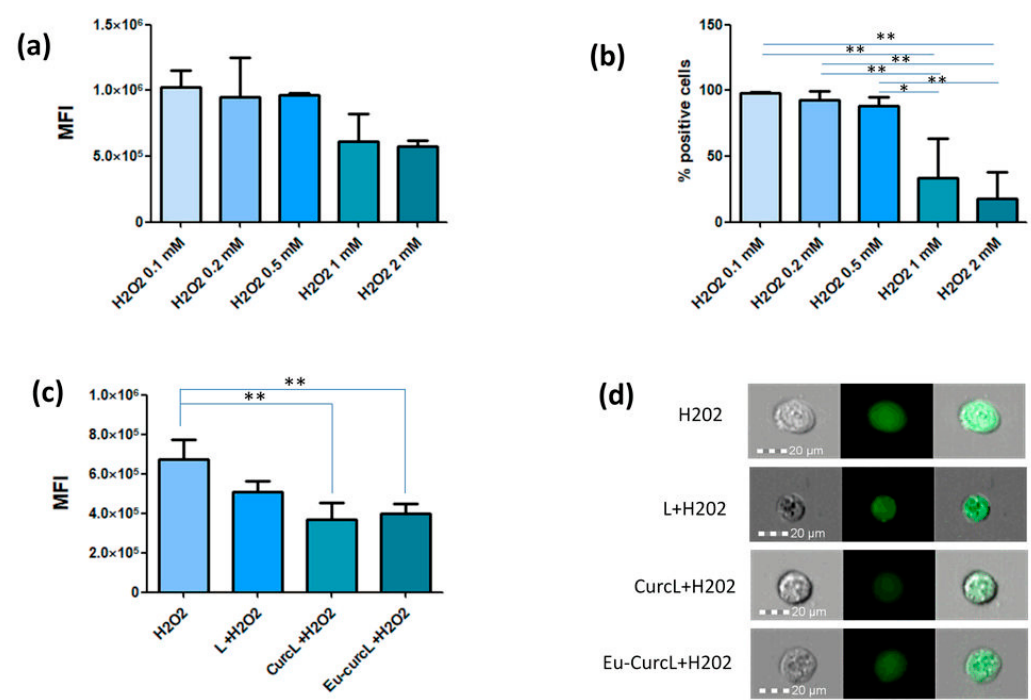
Figure 5. Mean fluorescence intensity (MFI) ( a ) and % positive cells ( b ) associated with oxidative stress as induced by H 2 O 2 . Panel ( c ) represents the anti-oxidative e ff ect of liposomes on the reactive oxygen species (ROS) levels induced by 0.1 mM H 2 O 2 . Data are shown as the mean ± SD of four replicates for each condition. * p < 0.05; ** p < 0.01. ( d ) The cells exemplificative of each experimental condition shown in ( c ) are shown as brightfield images (left column), fluorescence channel (middle column) and merge (right column).